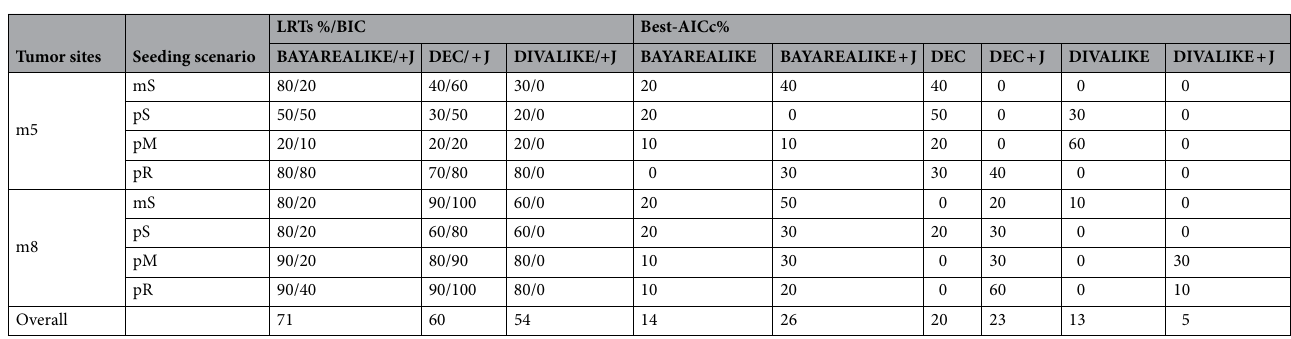
Table 2. The biogeographic model fits for 80 simulated datasets. Percent datasets in which the Likelihood Ratio Test (LRT) rejects the null hypothesis (LRTs%), and in which the model has the best AICc score are shown